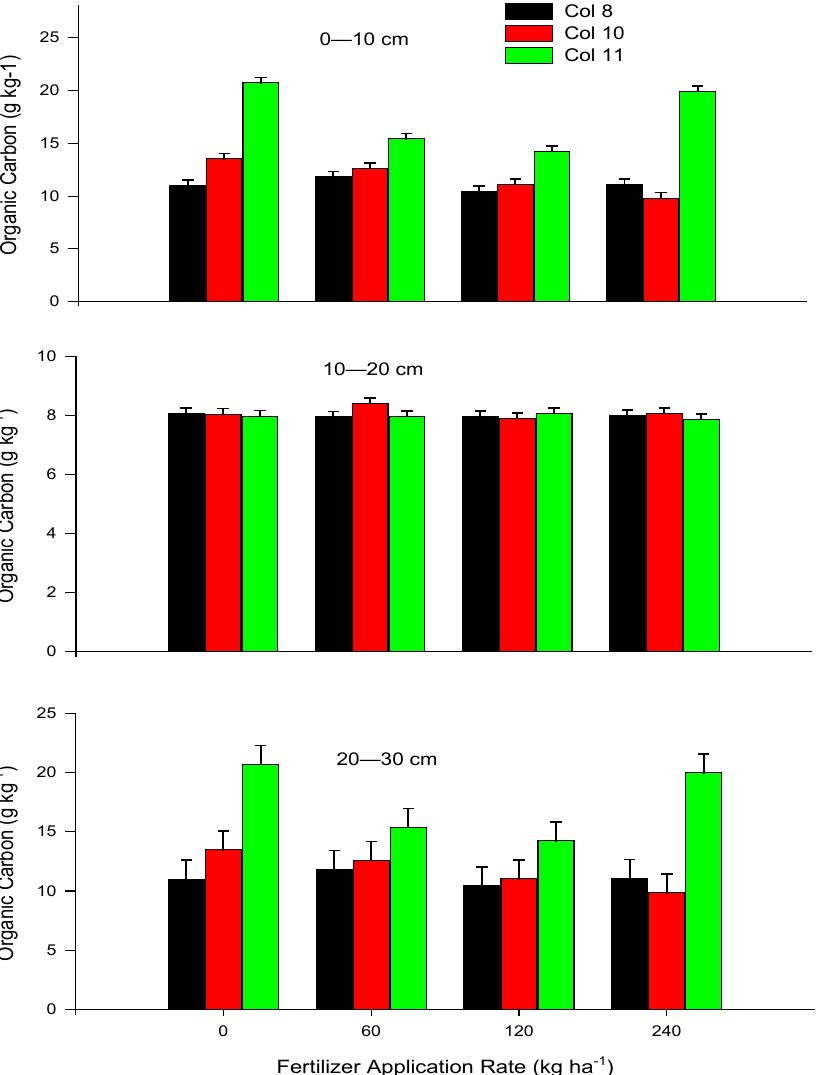
Figure 3. Organic carbon with depths and urea fertilizer application (kg N ha −1 ) for three tillage techniques.